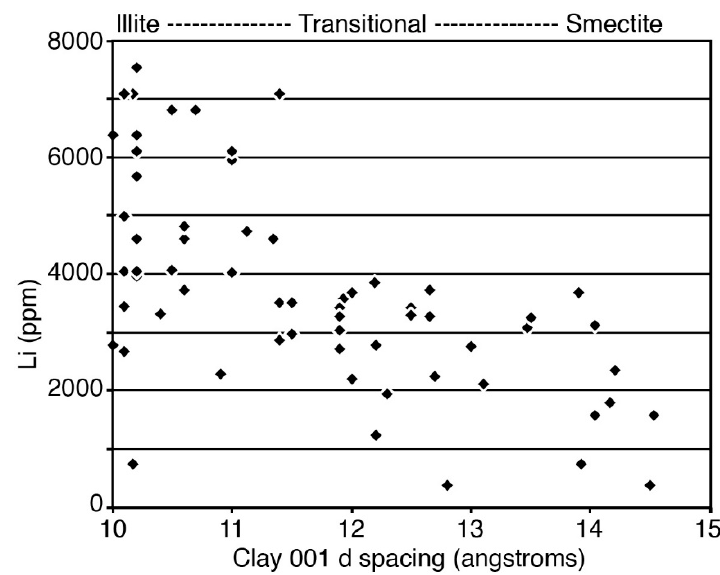
Figure 12. Interval lithium content plotted against d spacing for the 001 clay peak, drill holes WLC43, WLC62, WLC65, and WLC67.